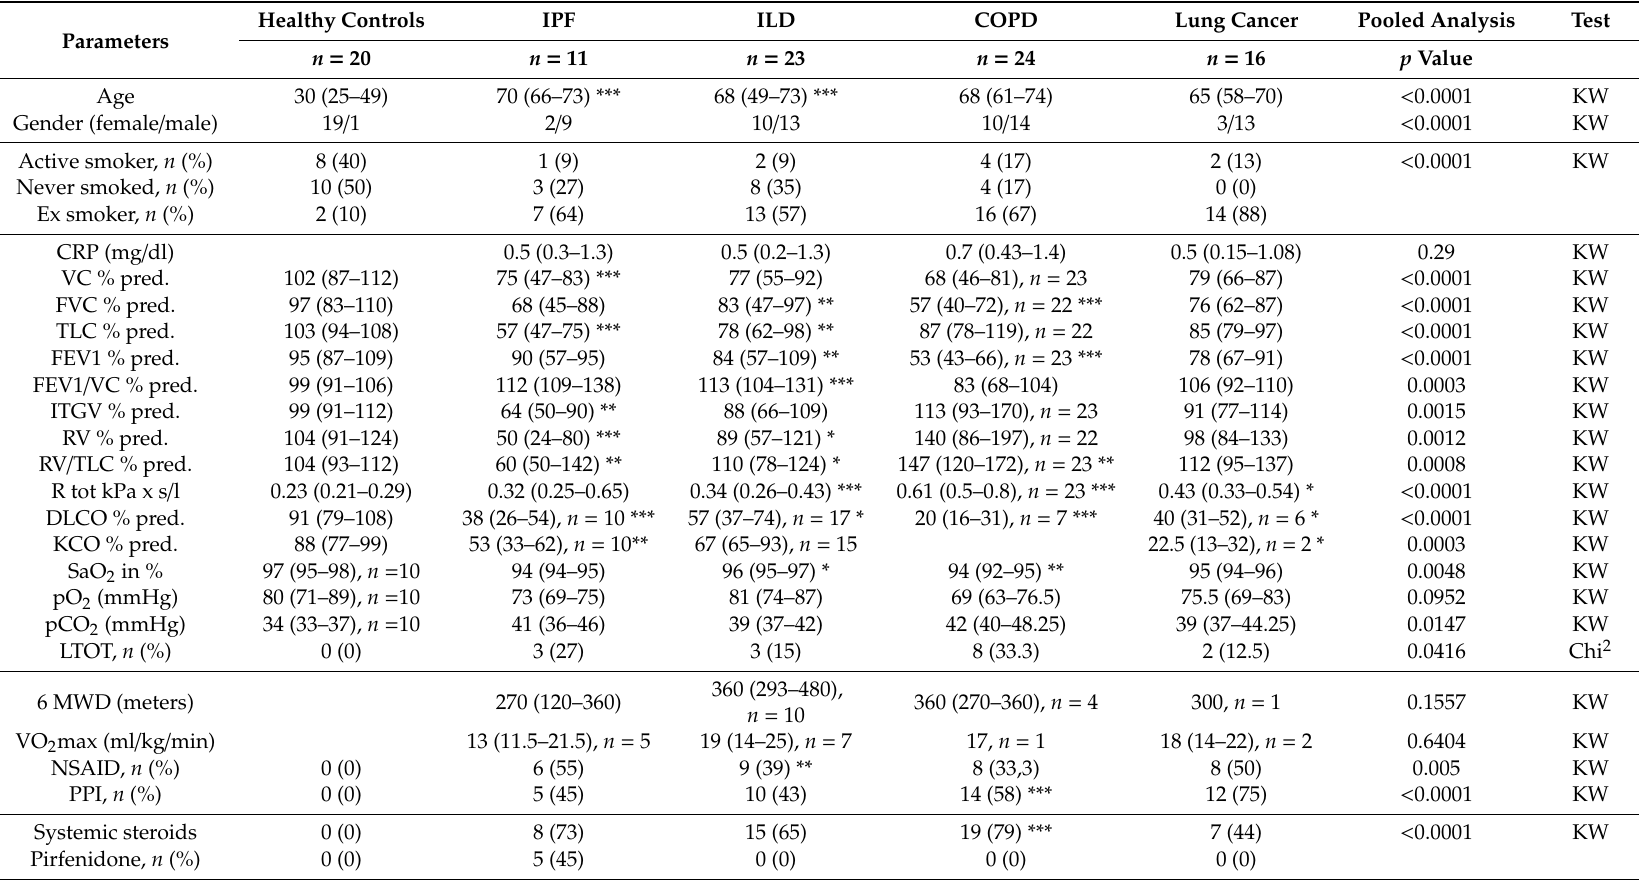
Table 1. Demographics and clinical and functional parameters in the IPF, ILD, COPD and LC cohort (FeNO